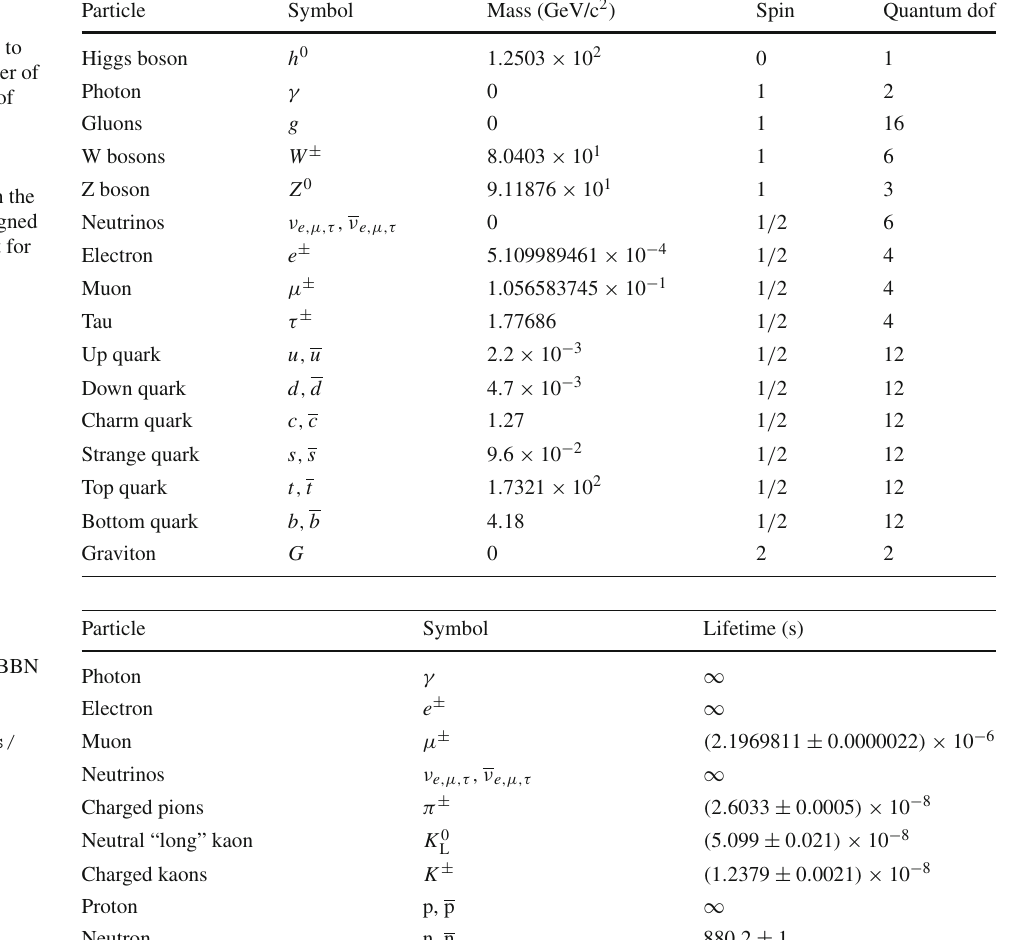
lifetime longer than 10 − 8 s, relevant for Early Universe/BBN studies [15,47] and used to